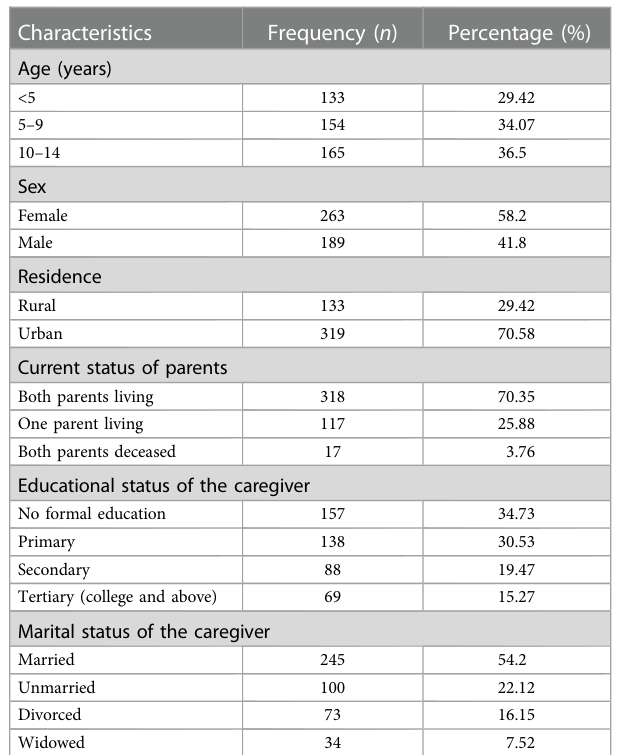
TABLE 2 Socio-demographic characteristics of HIV-infected children receiving ART at Amhara regional state comprehensive specialized hospitals, Ethiopia, 2022 ( n =452).